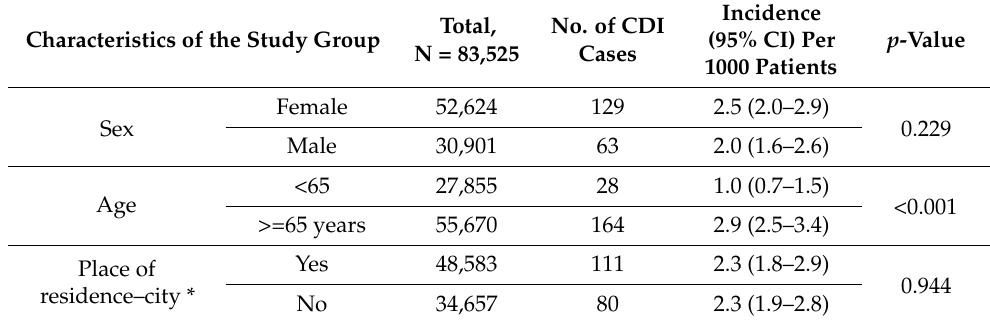
Table 1. Clostridioides difficile infection incidence in relation to patient and operation characteristics. Characteristics of the Study Group